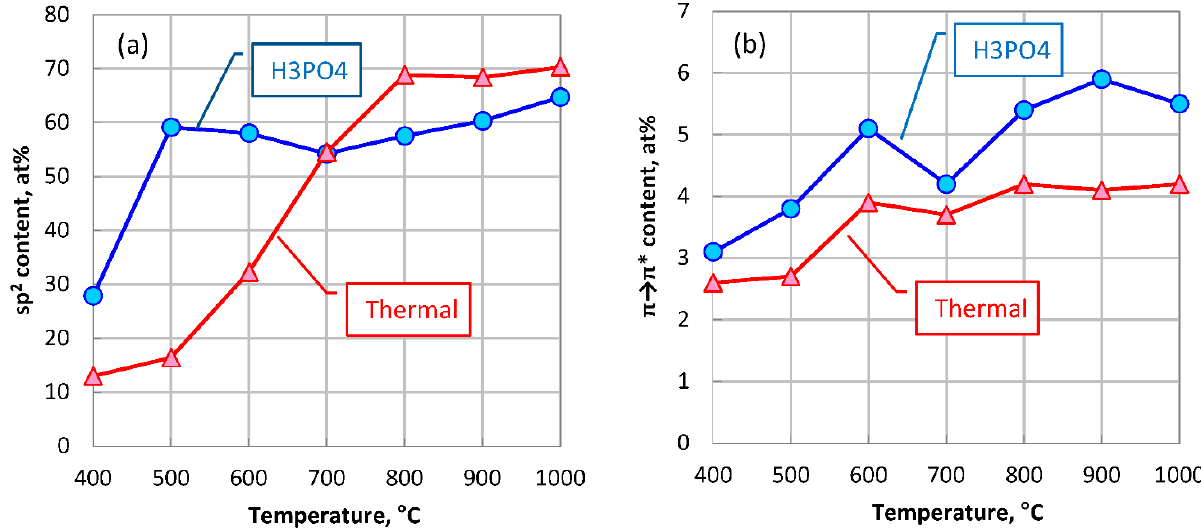
Figure 4. Temperature evolution of sp 2 -hybridized carbon content: ( a ) and π → π * shake-up signal ( b ) of polyimide-derived carbons obtained with (H 3 PO 4 -series) and without (Thermal-series) phosphoric acid at different temperatures.